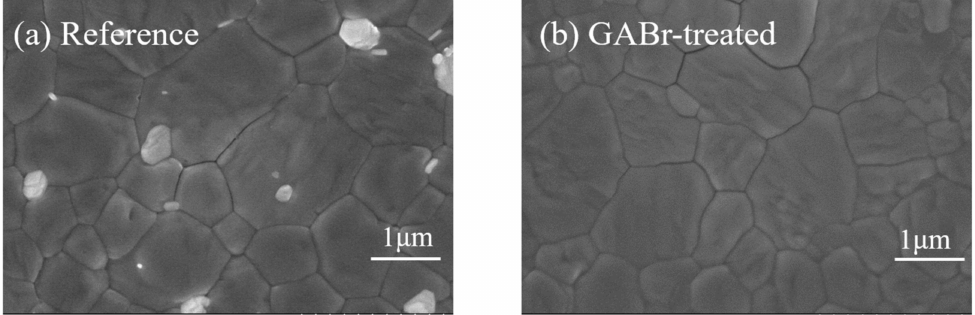
Figure 3. SEM images of ( a ) the reference film, ( b ) GABr-treated MAPbI 3 . According to the AFM profile of the pristine and GABr-treated MAPbI 3 film shown